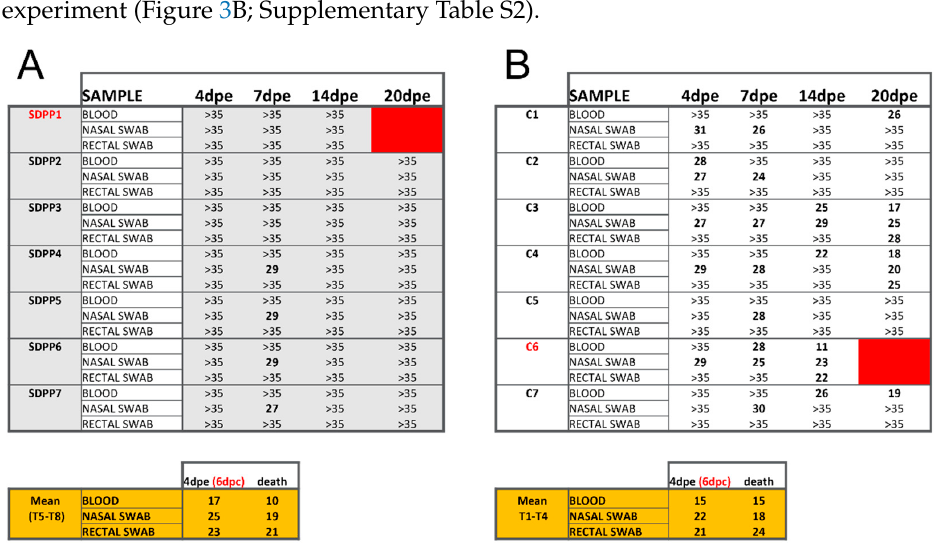
Figure 2. Rectal temperature recorded individually after Georgia 2007/01 exposure of pigs intrana-